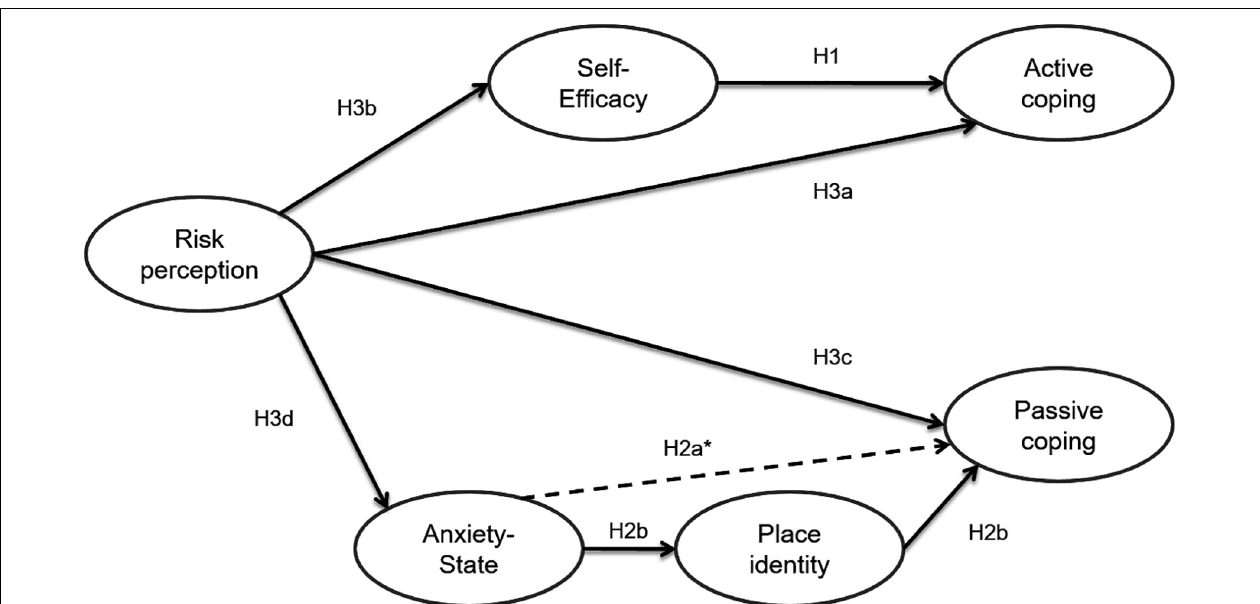
FIGURE 1 | Path model of predicted causal effects. ∗ The second model does not integrate Place identity. It considers only the direct relation between anxiety-state and passive coping willingness